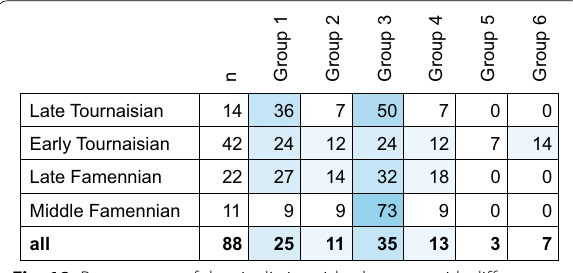
Fig. 18 Percentages of the six distinguished groups with different modes of septal distance in the stratigraphically successive assemblages containing the family